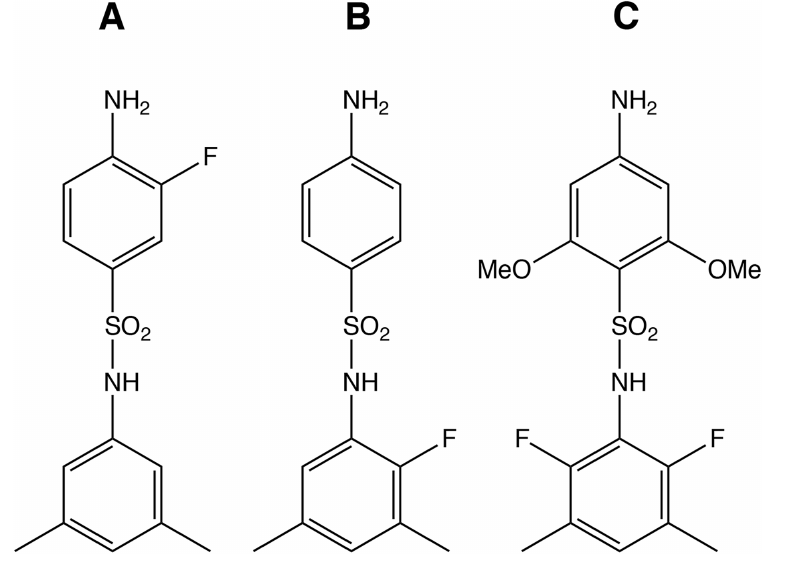
Figure 3 Sulfonamides. Chemical structures of docked ligands with highest af fi nity and selectivity; (A) SulfaE; (B) sulfaC and (C) SulfaH. The full names and af fi nities on Table